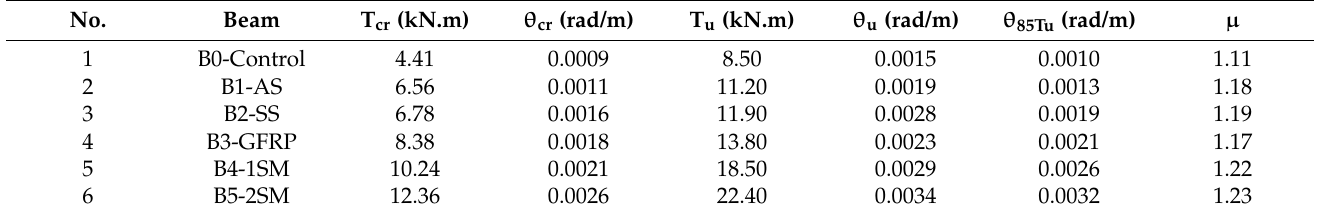
Table 7. Experimental test results.